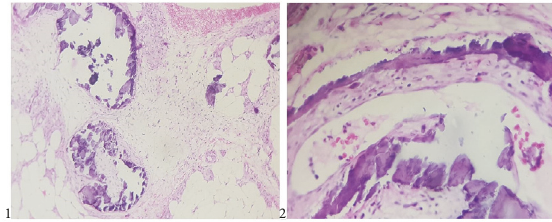
Figure 4: (1) A skin biopsy and adipose tissue in patient 2 with foci of necrosis, calcification of arteriolar walls, and necrotizing panniculitis in the context of a uremic calcifying arteriopathy. (2) Intimal thickening and fibrin thrombi in patient 2 skin biopsy.